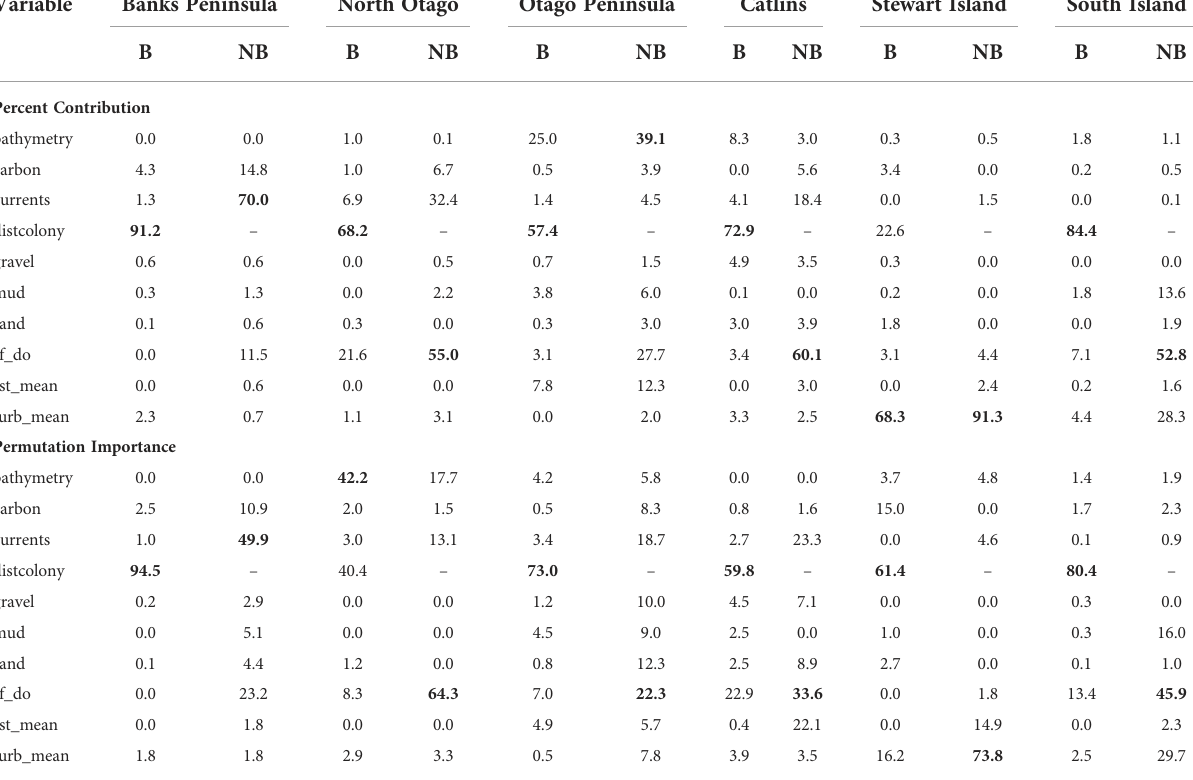
TABLE 3 Percent contribution and permutation importance (highest in bold) for the environmental variables used in the South Island and fi ve regional Maxent models that include (B; breeding) and exclude (NB; non-breeding) distance to colony as a predictor.